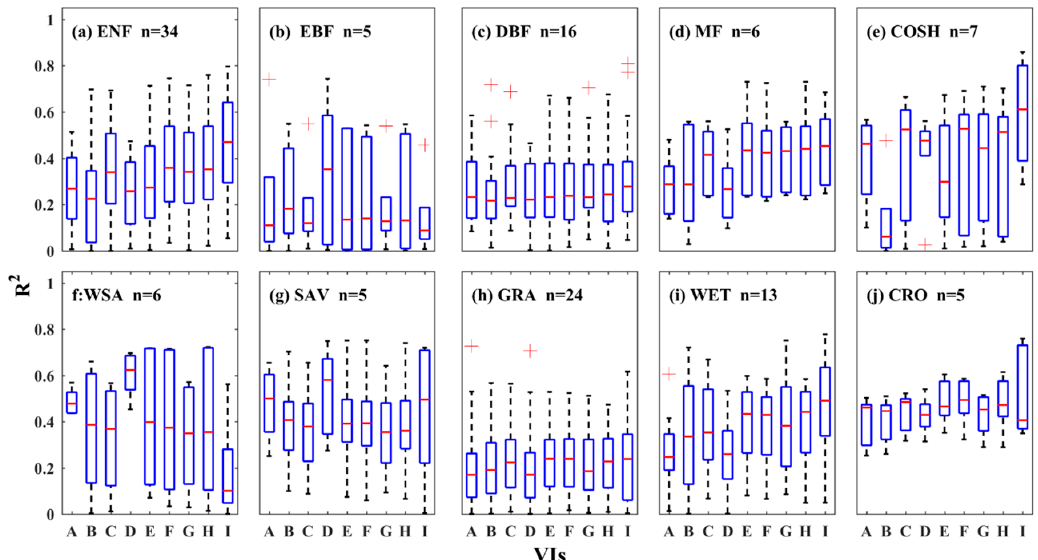
Figure 7. The boxplots of the R 2 for the relationships of monthly averaged VIs and MODIS GPP with water stress (f VPD ) for each biome with the total of 121 sites. The letters on the x axis stand for: A -